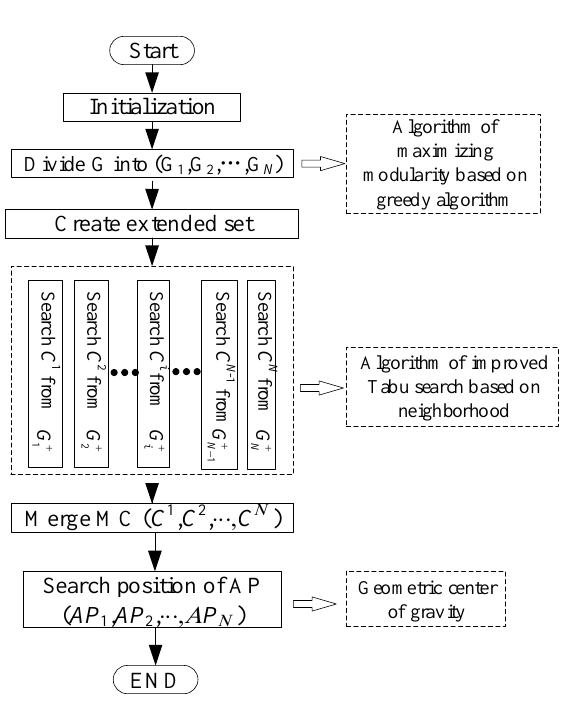
Figure 2. The distributed parallel improved Tabu search algorithm.